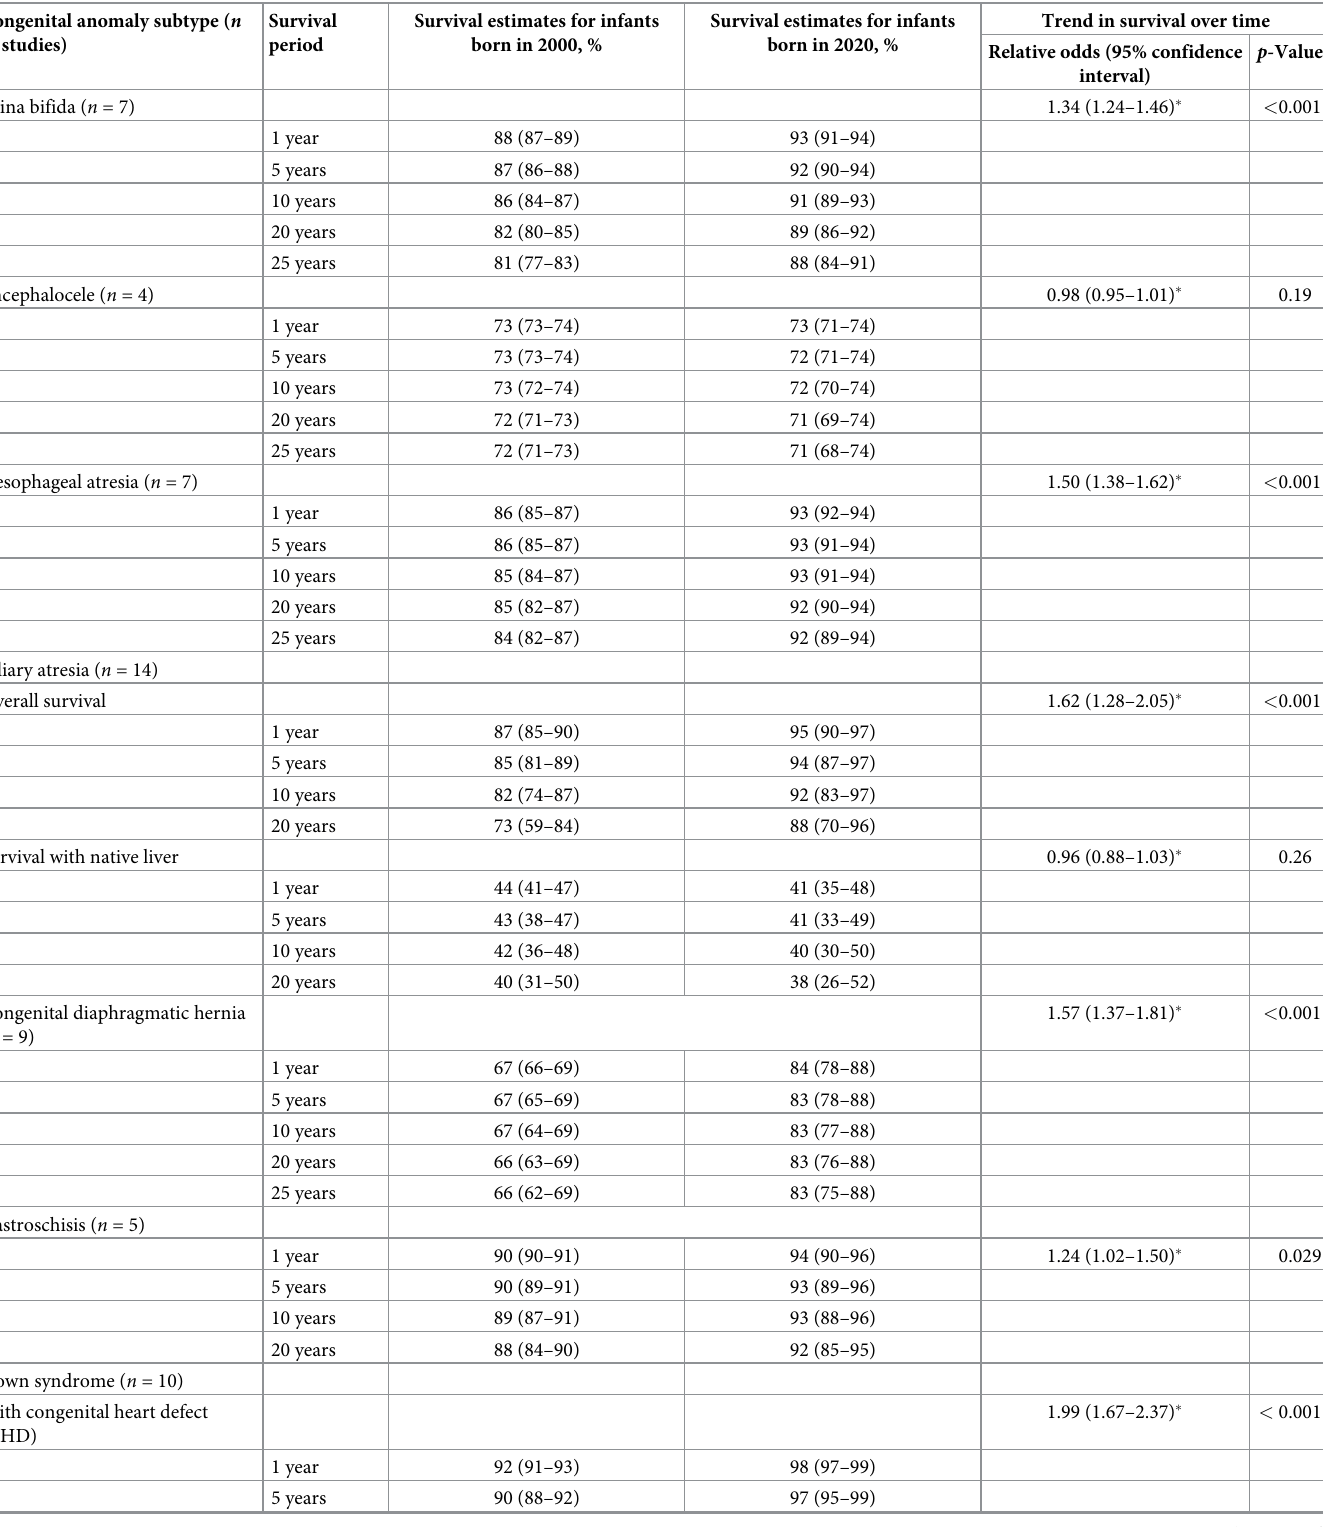
Table 3. Predicted survival estimates for children born with selected congenital anomalies in 2000 and 2020 (results of the